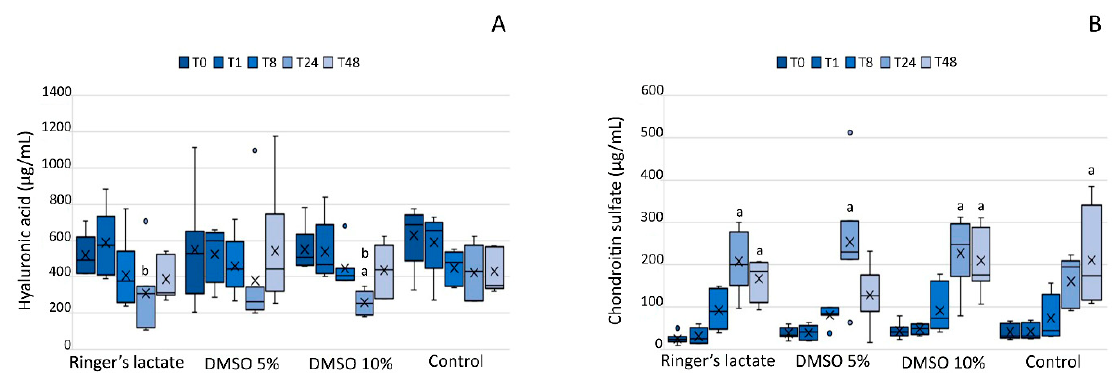
Figure 4. ( A ) Hyaluronic acid and ( B ) chondroitin sulfate concentrations (µg/mL) in the synovial fluid. Hyaluronic acid and chondroitin concentrations are shown as box plots, indicating the median ( − ), mean (×), and first and third quartiles. a Statistically significant differences compared to the baseline values, T1 and T8 ( p < 0.05). b Statistically significant differences compared to T1 ( p < 0.05).